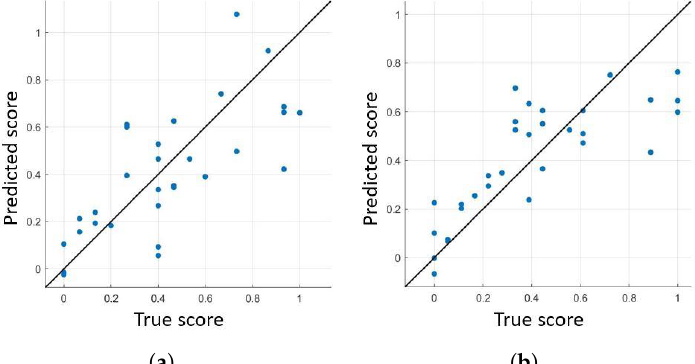
Figure 8. Regression results for patients under different pharmacological condition. Data are plotted using a scatter plot and the regression line is reported as the best fit line. ( a ) Patients under dopaminergic therapy. ( b ) Patients not under dopaminergic therapy.